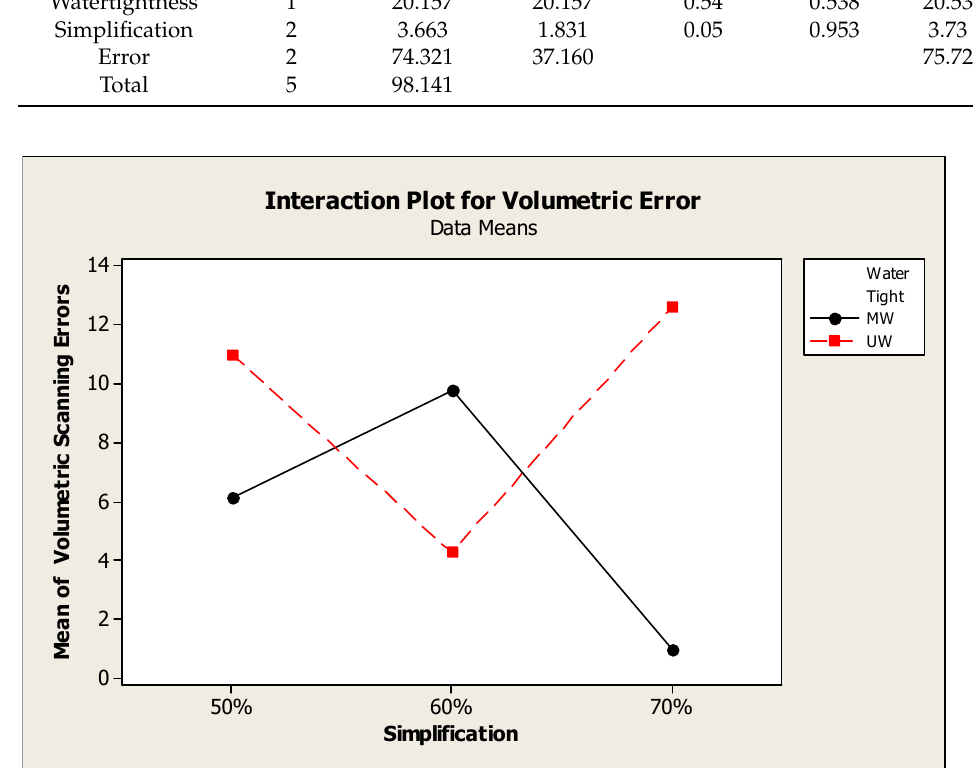
Figure 8. Interaction plots for volumetric error (mode D).